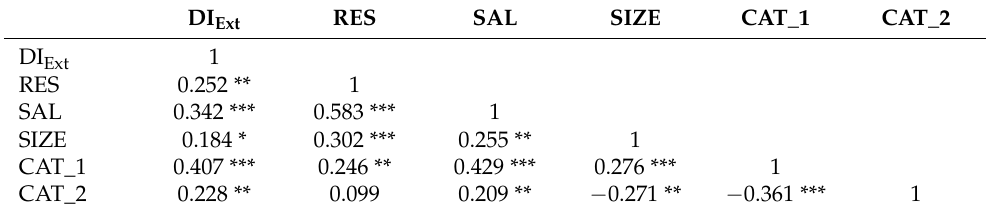
Table 7. Correlation matrix for external environment.